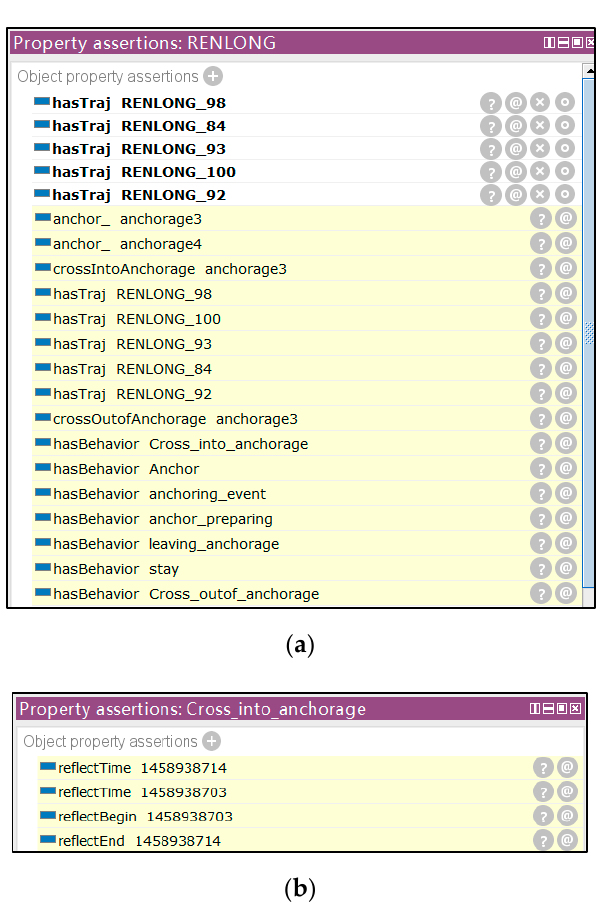
Figure 14. Reasoning results of behavior occurred in anchorage. ( a ) Deduced behaviors occurred by RENLONG; ( b ) The time of occurrence of the behavior Cross_into_anchorage, involving begin and end moments.